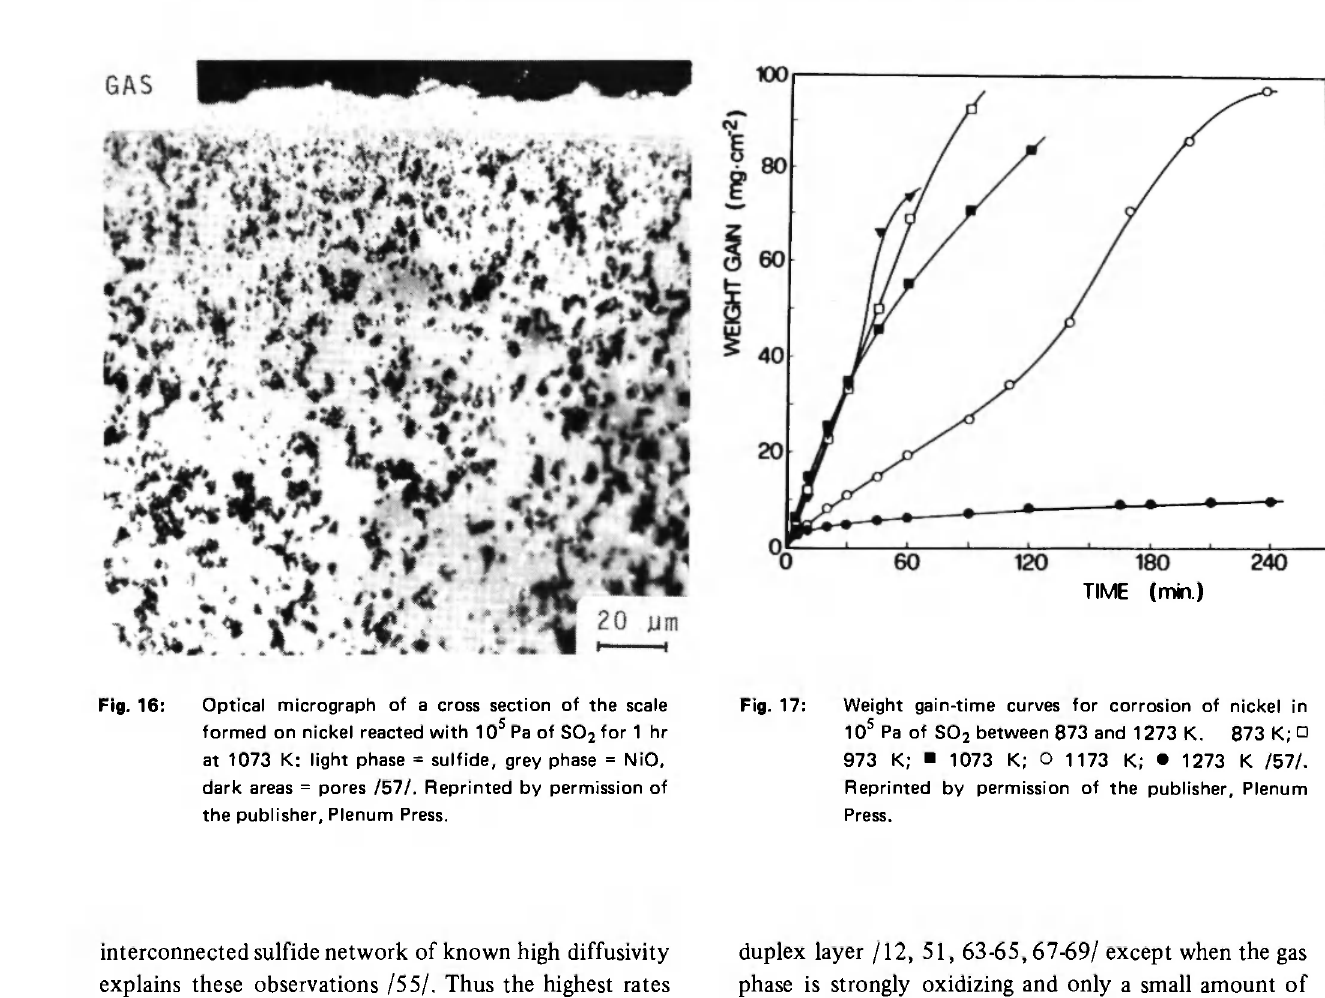
Fig. 17: Weight gain-time curves for corrosion of nickel in 10 5 Pa of S0 2 between 873 and 1273 K. 873 Κ; α 973 Κ; • 1073 Κ; Ο 1173 Κ; · 1273 Κ